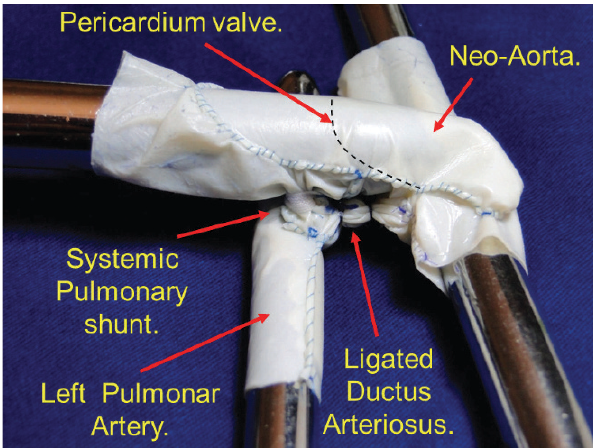
Figure 5 - The implantation of a bovine pericardium patch from the anterior opening of the pulmonary trunk to the aortic arch. This patch extends to the beginning of the descending aorta and gives rise to the anterior wall of the neo-aorta. The dashed line represents the valve suture on